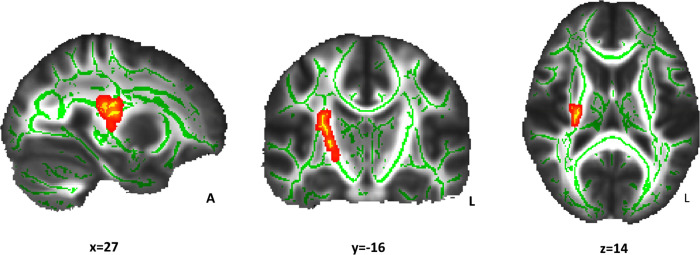
Interaction effect of Fractional Anisotropy (FA) and loss accuracy between groups.The red-yellow color indicates the white matter clusters that showed a significant interaction between FA and loss avoidance accuracy (at the indicated coordinates) between the normal-weight and overweight groups (α<0.05, threshold-free cluster enhancement and family-wise error correction).The mean skeleton of FA is shown in green. Right white matter tracts include the external capsule, superior and posterior corona radiate and posterior limb of internal capsule. Coordinates are presented in Montreal Neurological Institute (MNI) template space. A: anterior; L: left.